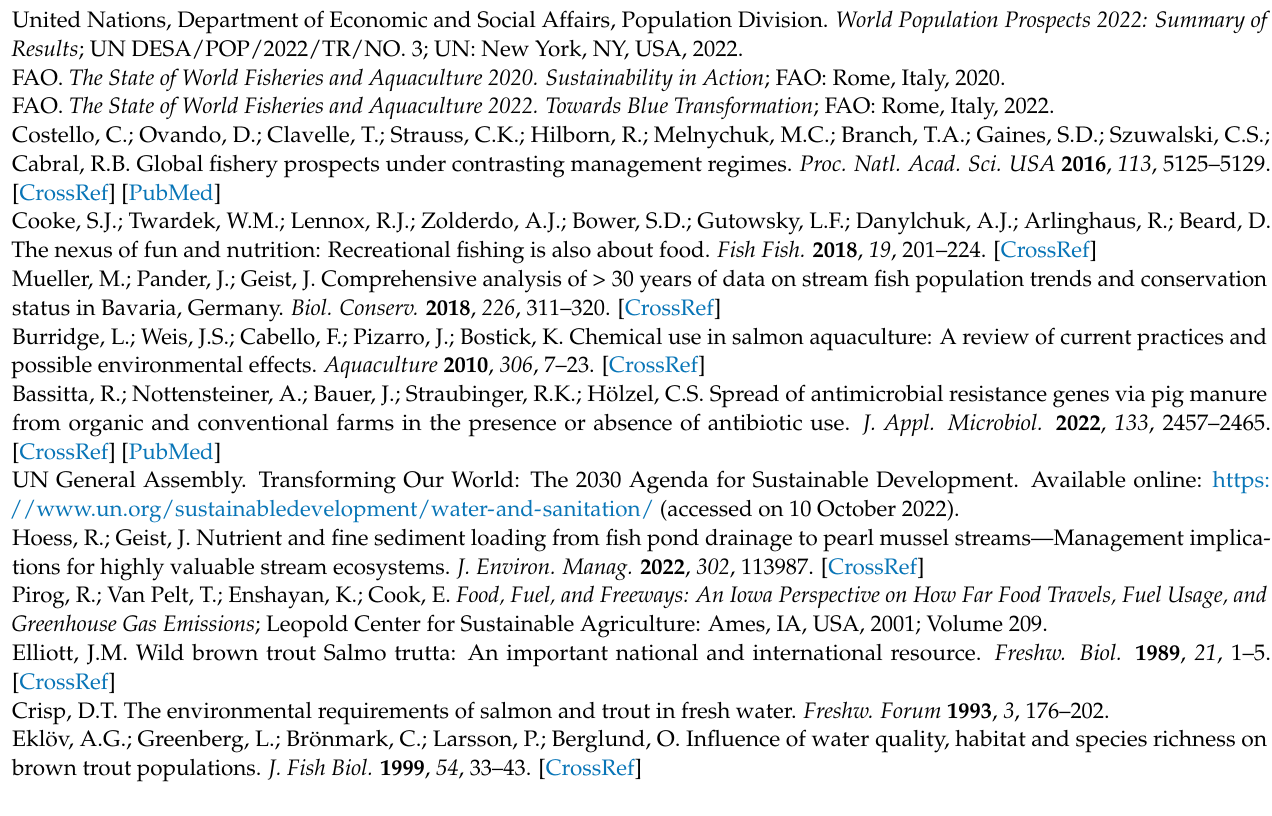
Table S2: zOTU Table of all